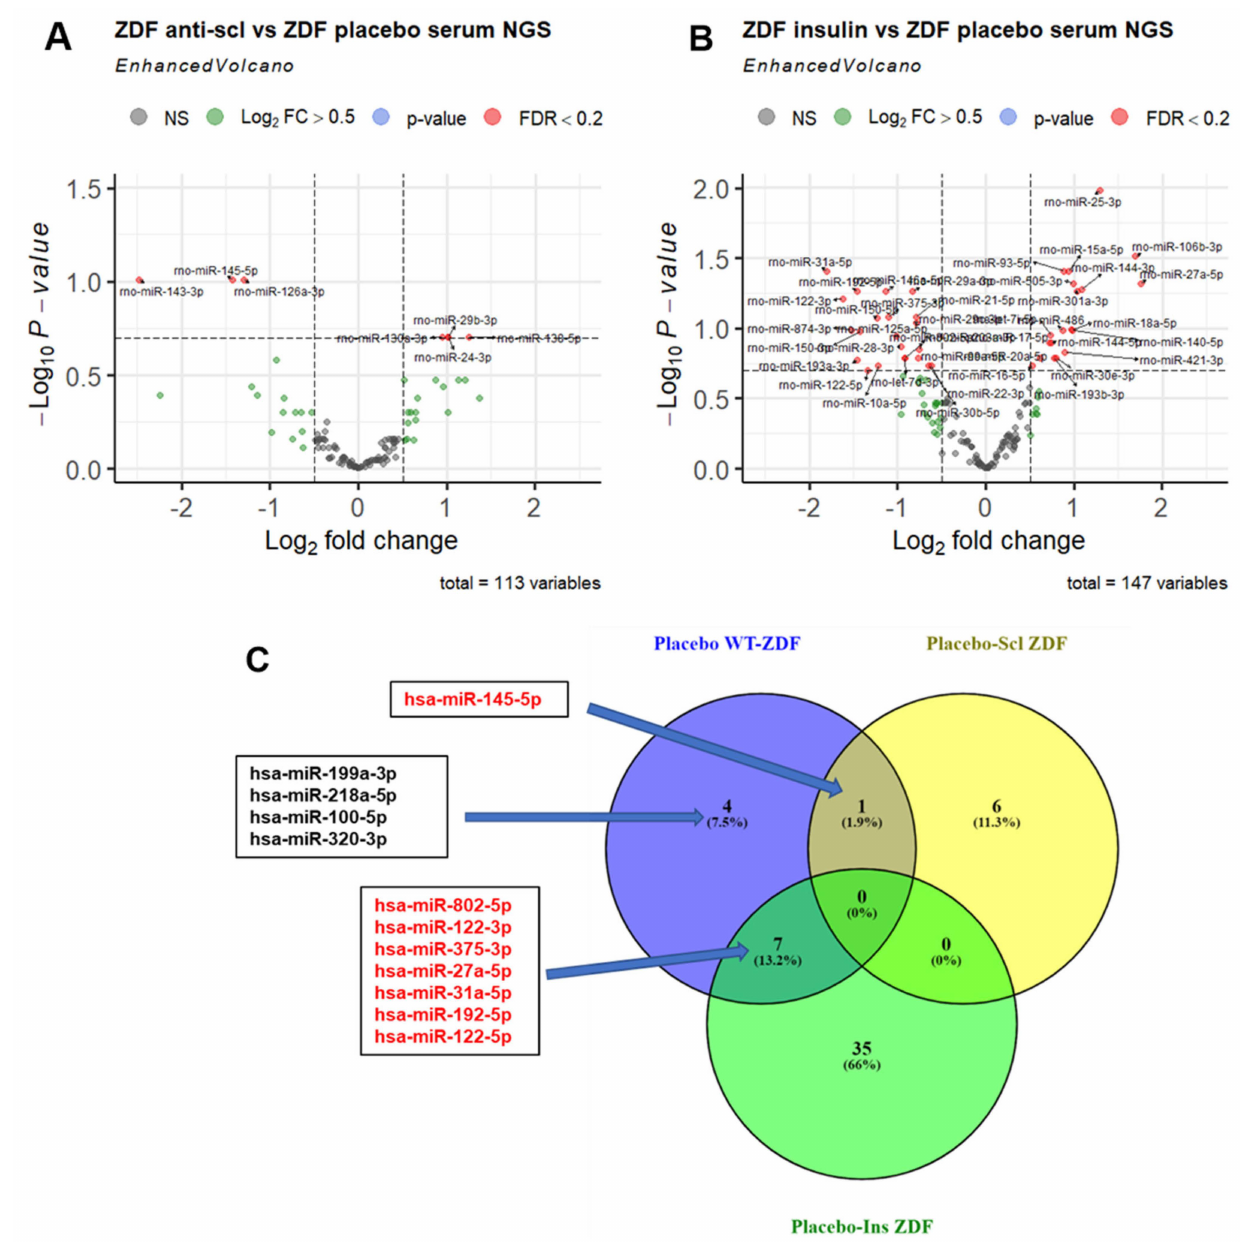
Figure 3. NGS-based discovery of miRNA changes in serum of ZDF rats under anti-sclerostin and insulin treatment compared to placebo treatment. ( A , B ) Volcano plots depict the log2-transformed fold change and log10-transformed adjusted p -values for the contrast (ZDF placebo, n = 5 vs. ZDF treatment, n = 4) in serum. miRNAs with Benjamini–Hochberg-adjusted p -values < 0.2 (FDR < 20%) are highlighted as separate group in red. ( C ) VENN comparison of miRNAs dysregulated in placebo- treated ZDF vs. WT rats (left circle) and miRNAs affected by either insulin (bottom circle) or anti-sclerostin treatment (right circle) (FDR < 20%). miRNAs that are dysregulated in the ZDF model and rescued by treatment are highlighted in